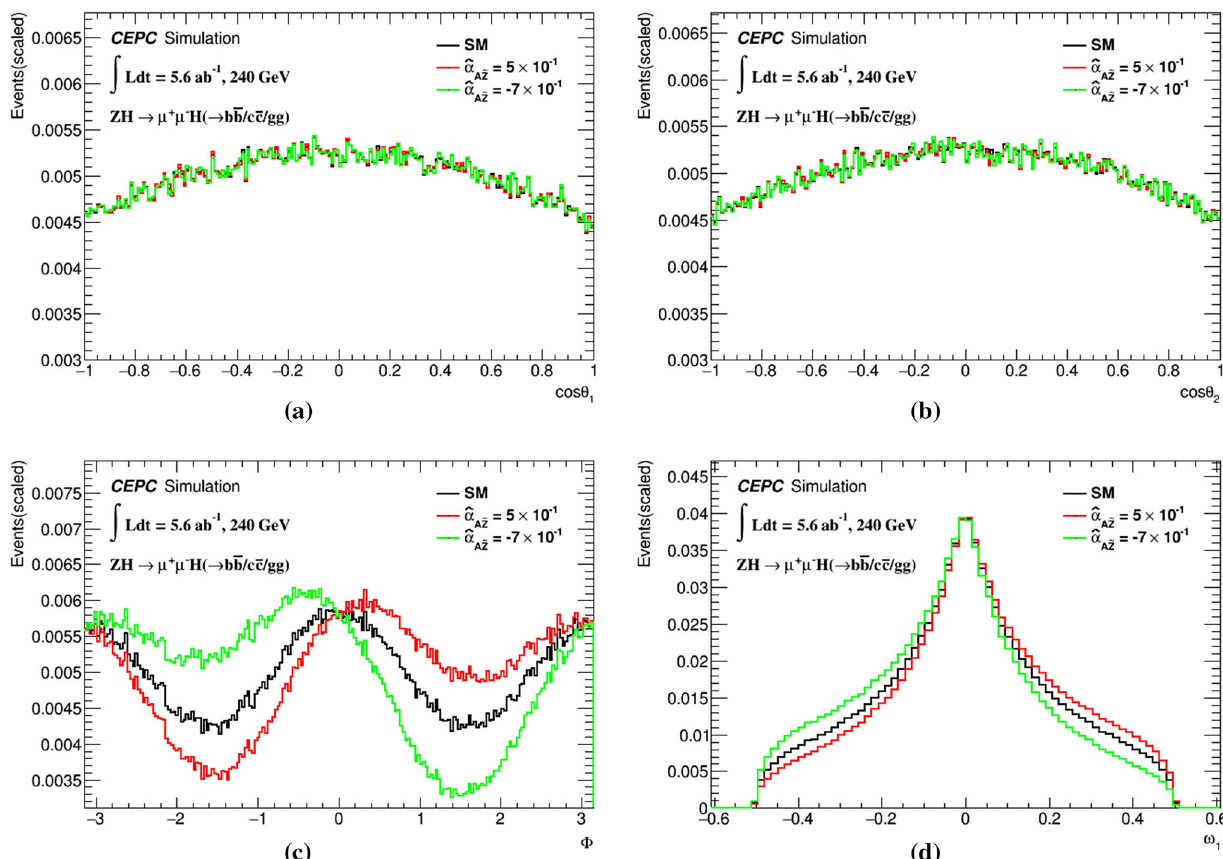
Fig. 1 Parametric curves with different ˆ α values. The optimal variable ω 1 is defined in the text. (The value of ω 1 here is multiplied by 1000 for A ˜ Z numerical